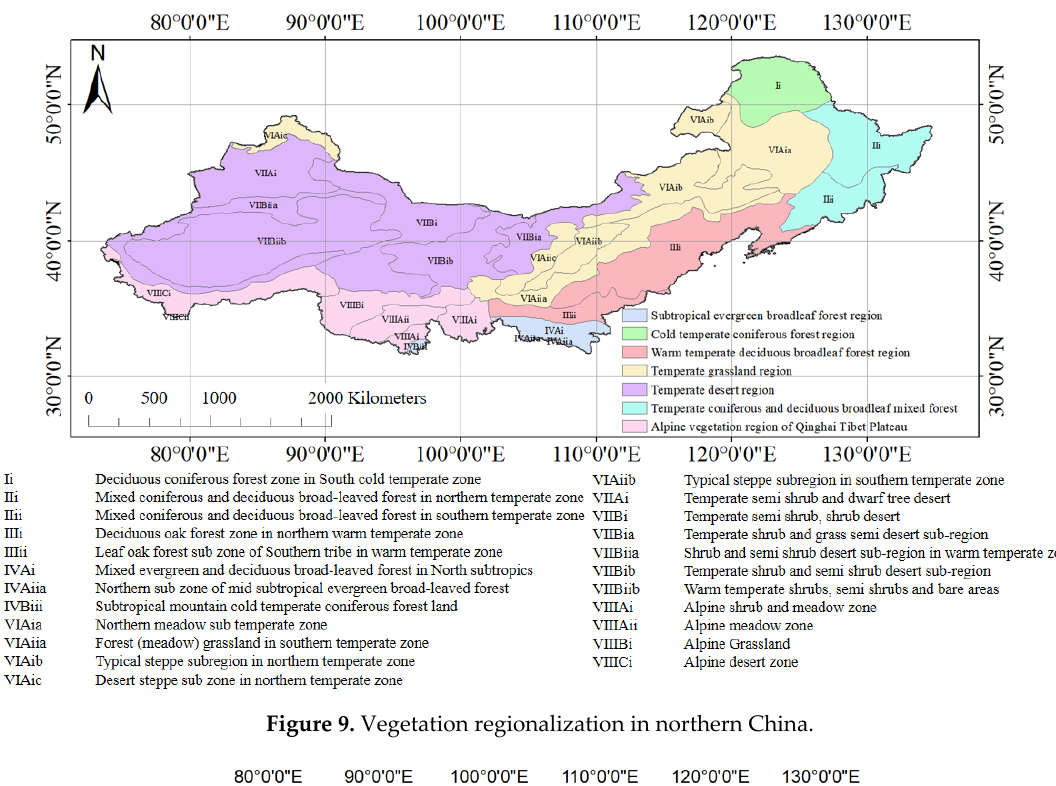
Figure 9. Vegetation regionalization in northern China.